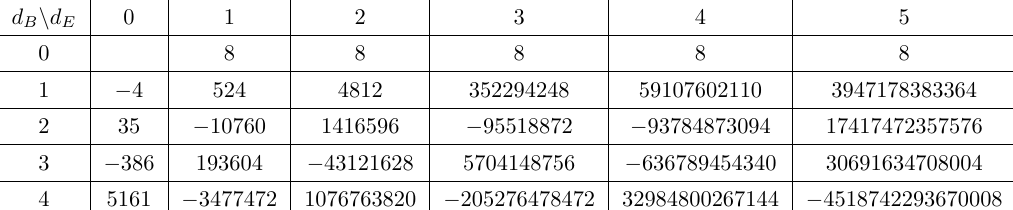
for the genus ( g ) = (0 , 1) . L , g R ( d B ,d E )